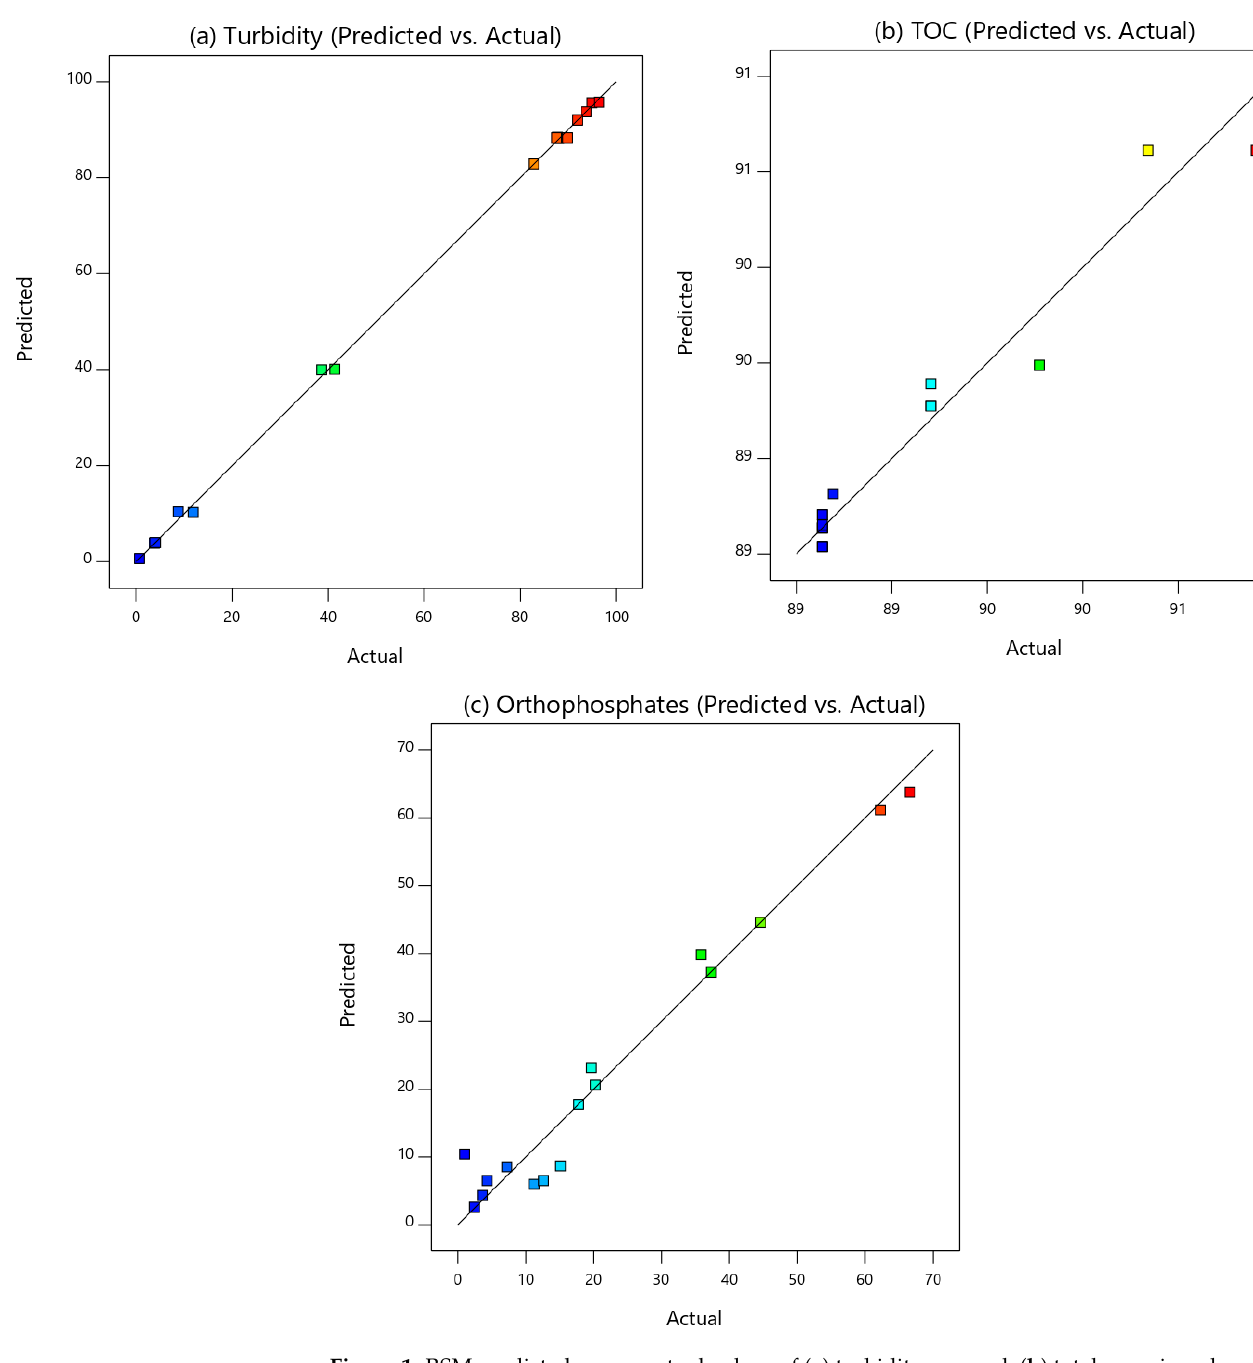
Figure 1. RSM predicted versus actual values of ( a ) turbidity removal, ( b ) total organic carbon (TOC) removal, and ( c ) orthophosphates removal.